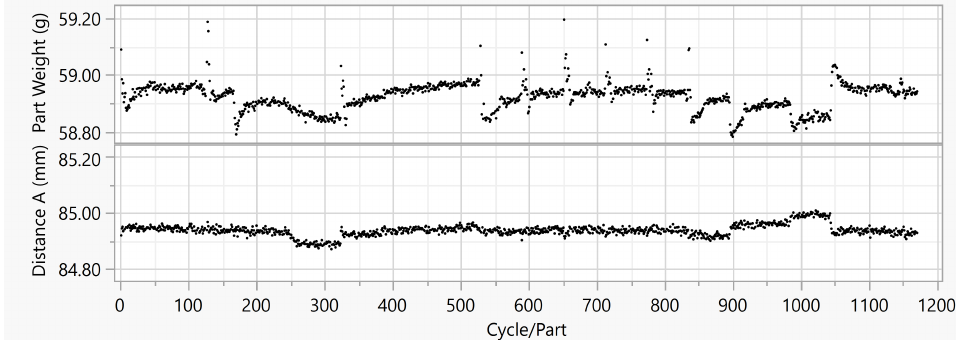
Figure 2. Part weight and Distance A vs. cycle or part in Housing Part data set.